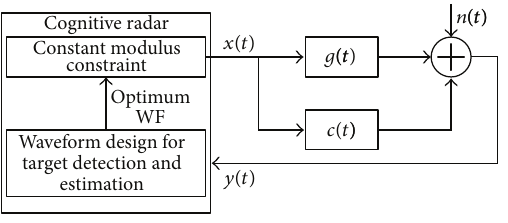
Figure 3: Closed-loop radar system.